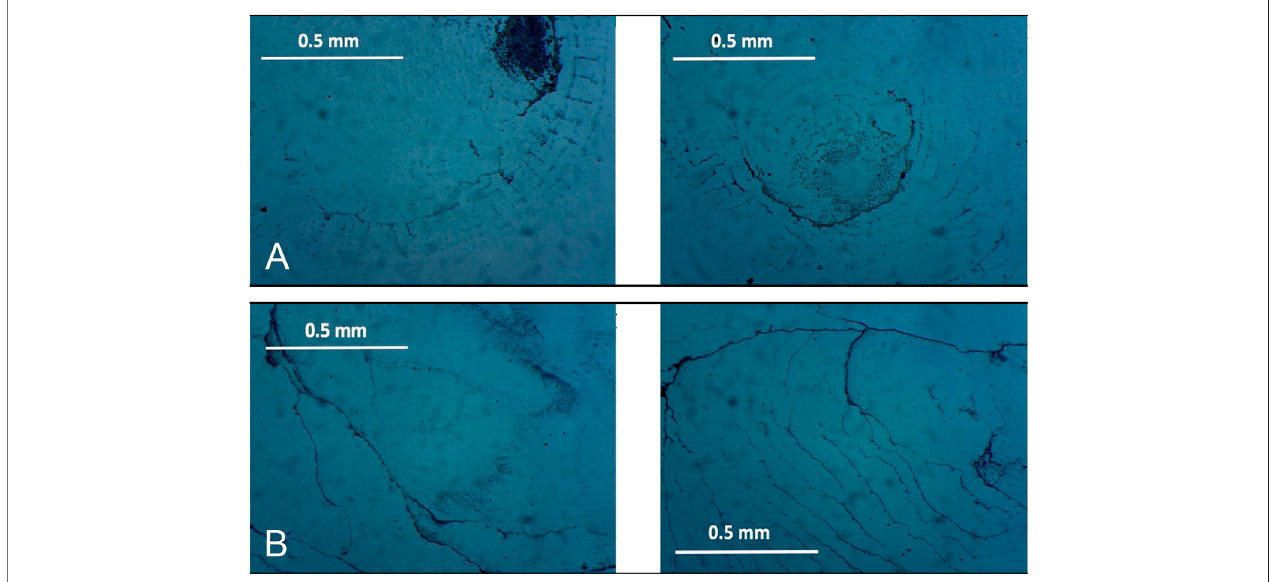
FIGURE 11 | Examples of photos of microsphere distribution in dried drops in 1 × 10 – 27 M HyFn (upper row, (A) ). ( (B) – lower row) – examples of photos of microspheredistributionindriedwaterdroplets,correspondingtoaHyFndilutionof1 × 10 – 27 M.Hereawavydistributionofmicrospheresisobserved,butitdiffersfrom dense accumulations in drops with 1 × 10 – 27 M HyFn.